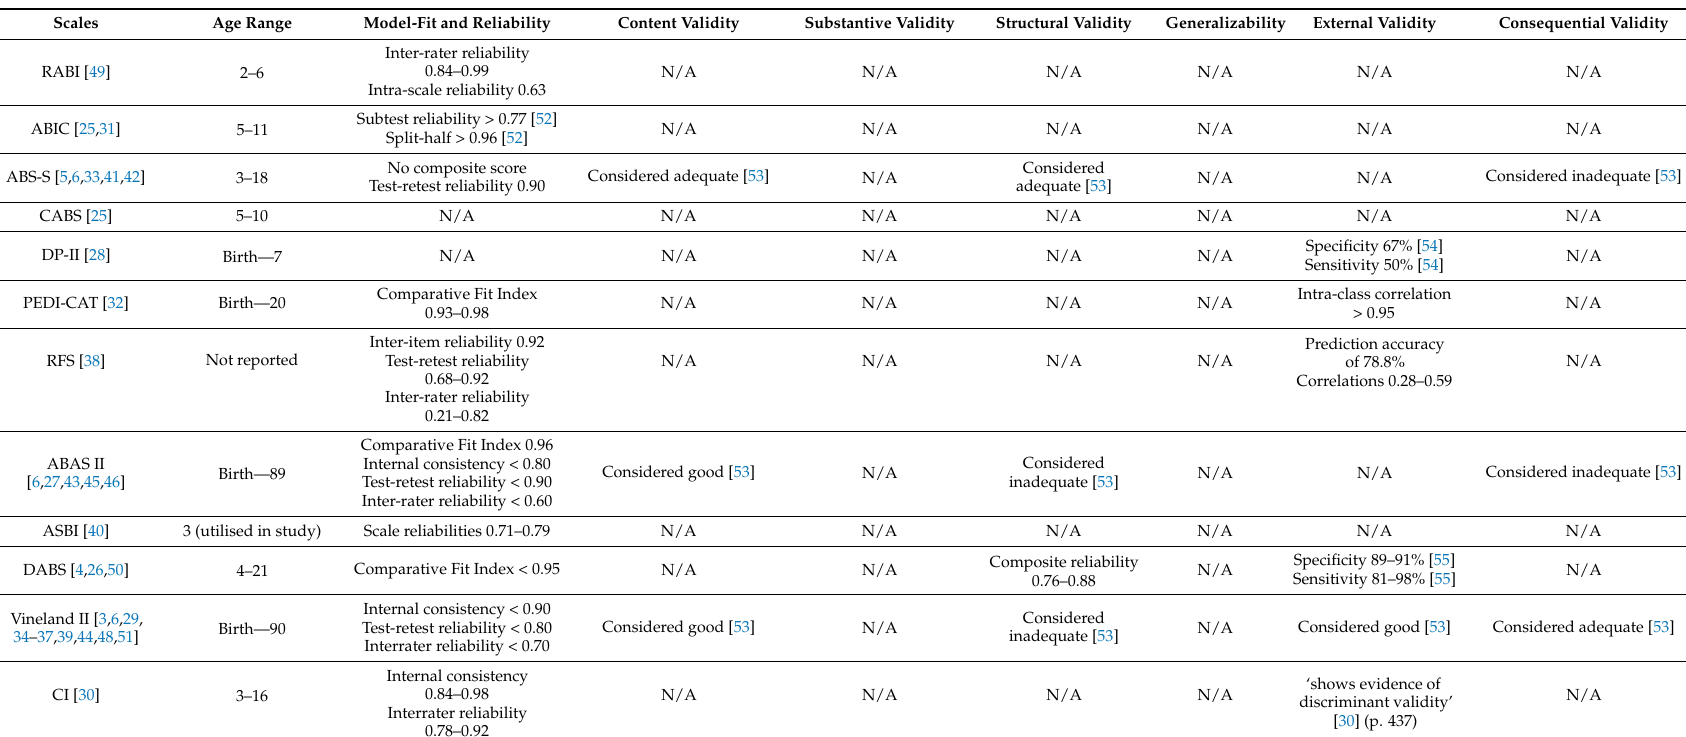
Table 5. Available psychometric properties for identified assessment